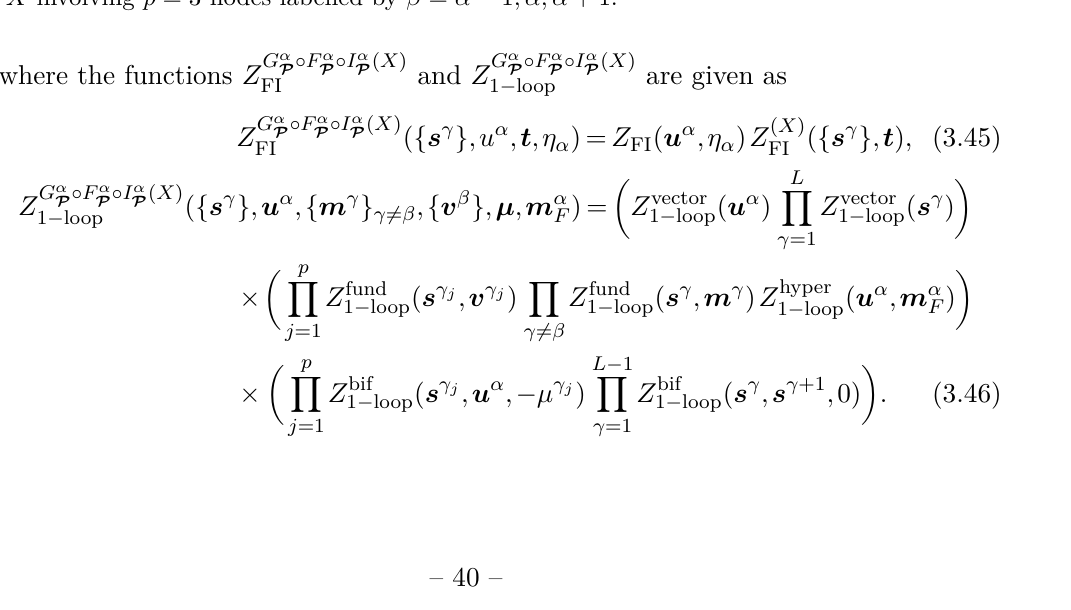
operation on a generic linear ◦ I α P P